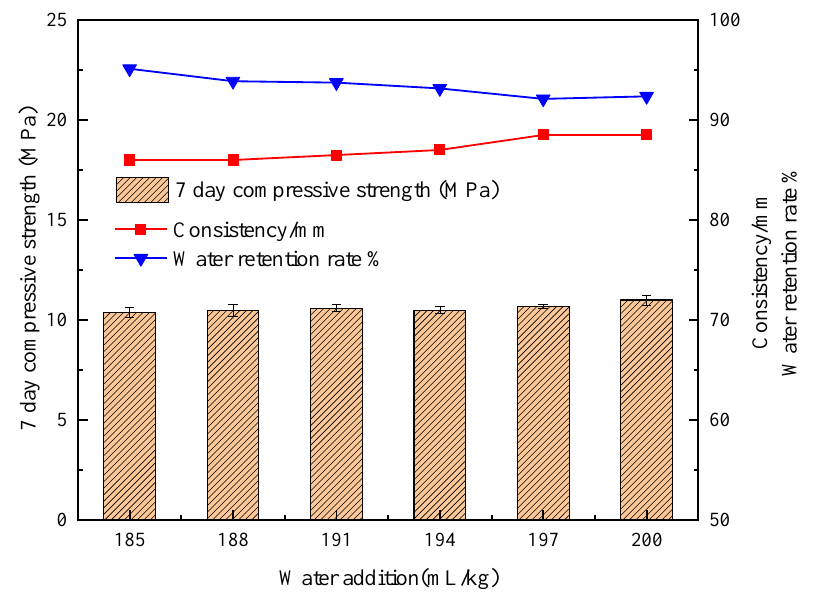
Figure 7. Effect of water addition on properties of dry-mixed mortar.